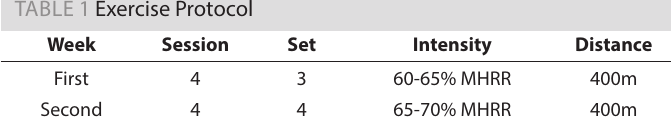
TABLE 1 Exercise Protocol